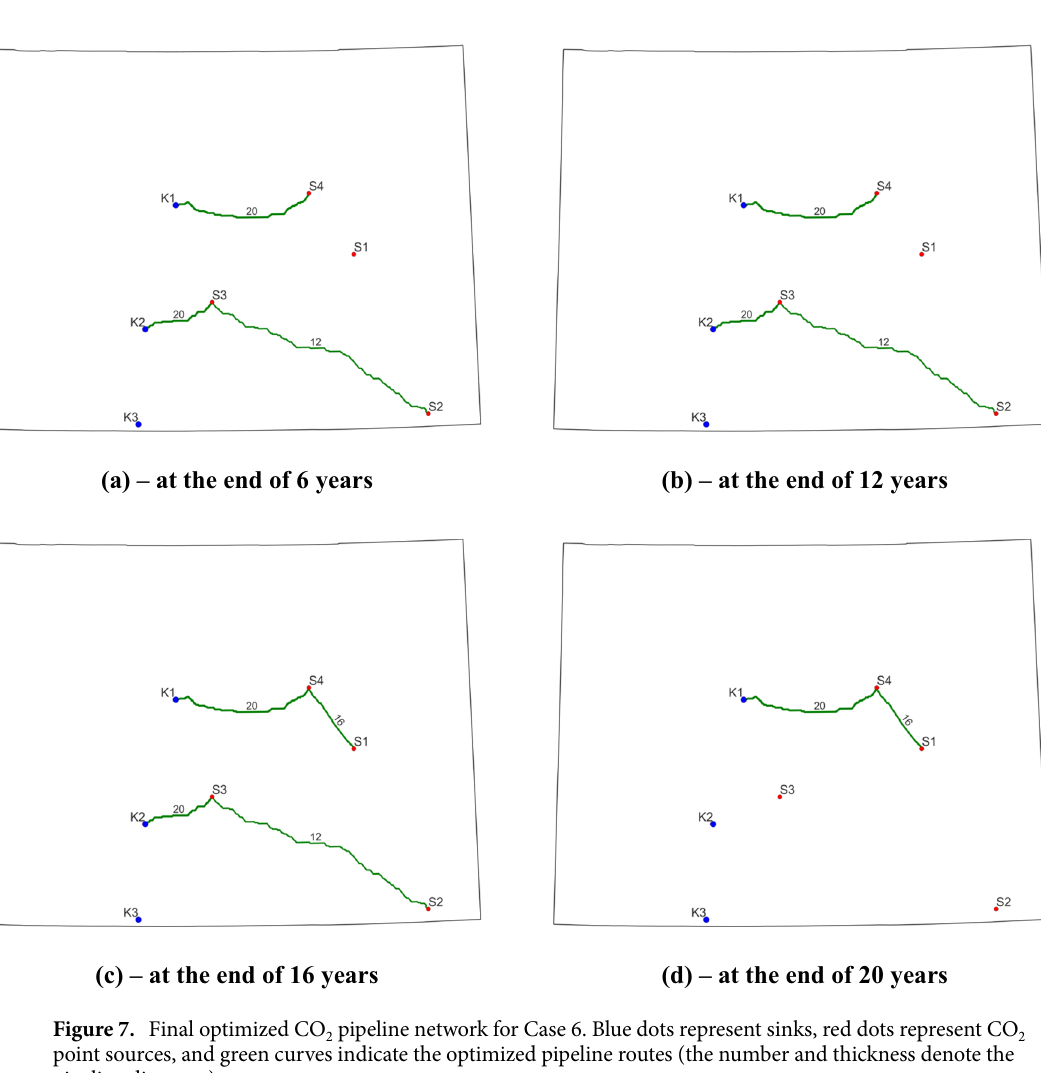
Figure 7. Final optimized CO 2 pipeline network for Case 6. Blue dots represent sinks, red dots represent CO 2 point sources, and green curves indicate the optimized pipeline routes (the number and thickness denote the pipeline